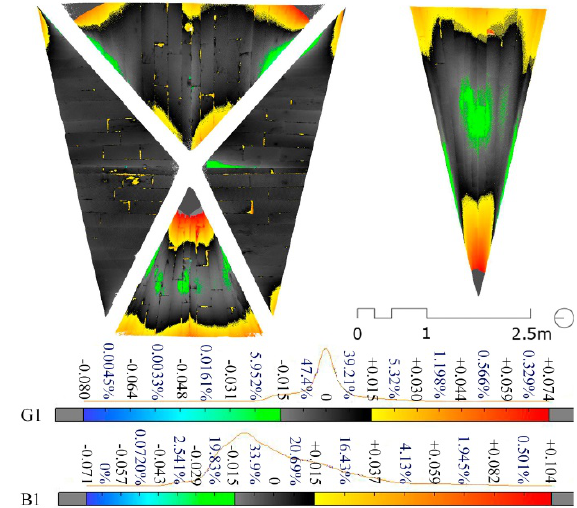
Figure 9: Study of flatness of the webs of vaults G1 and